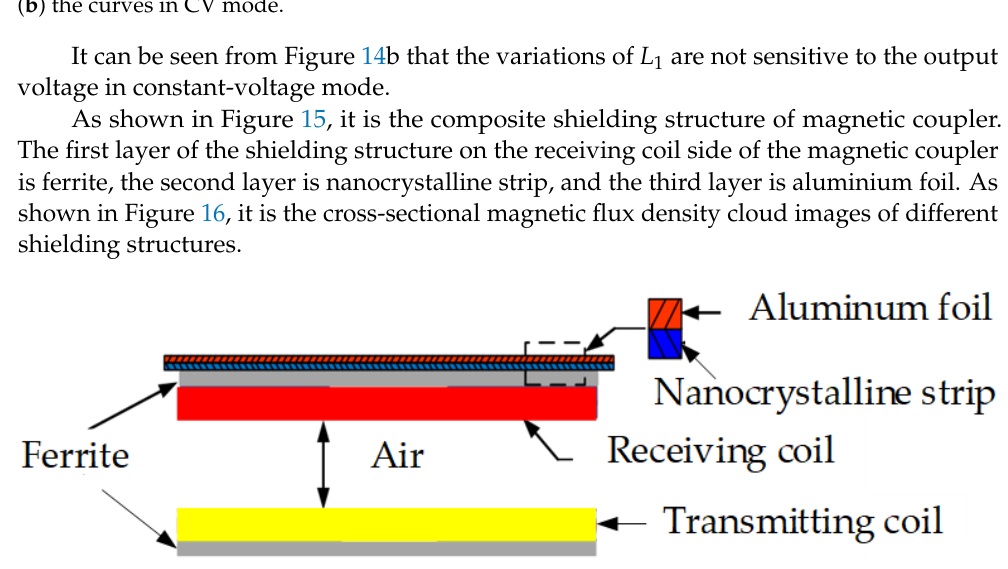
Figure 14. Normalized output with varying normalized parameters. ( a ) The curves in CC mode; ( b ) the curves in CV mode.